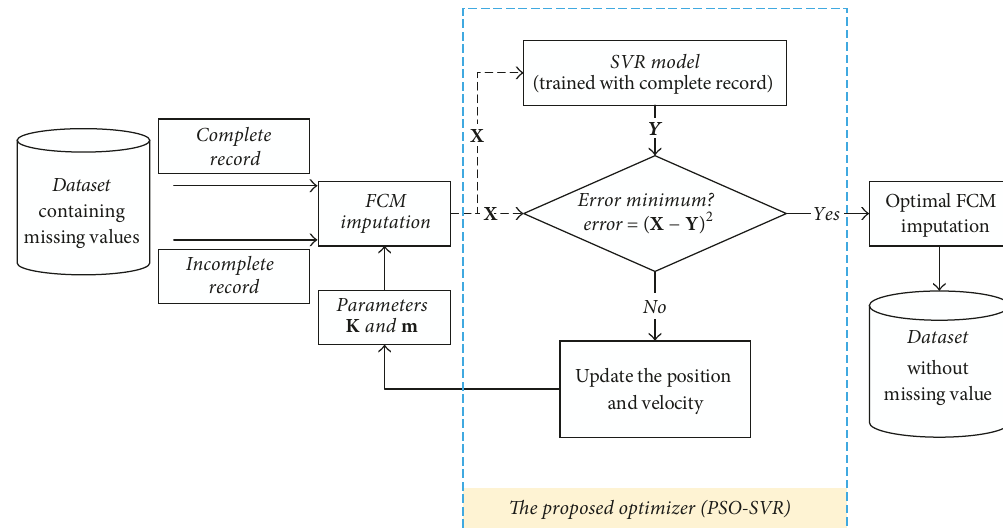
Figure 5: The flowchart of PSO-SVR-FCM-based imputation